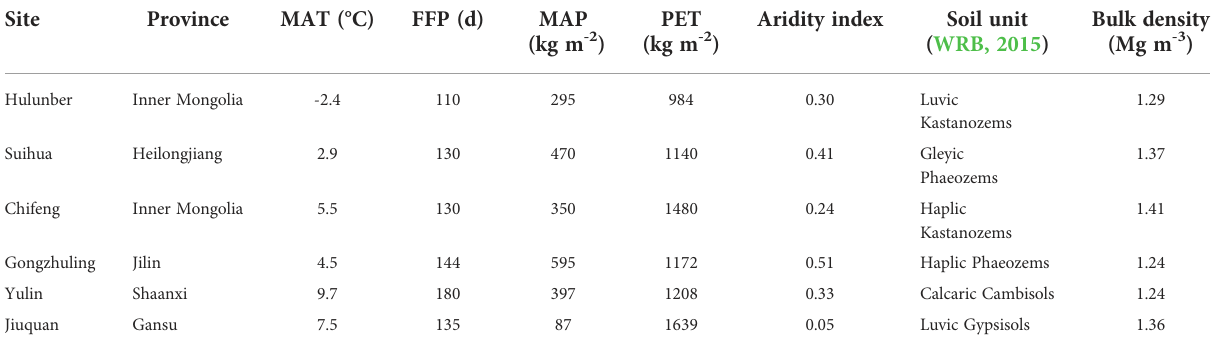
TABLE 1 Climatic and soil characteristics of the research sites.